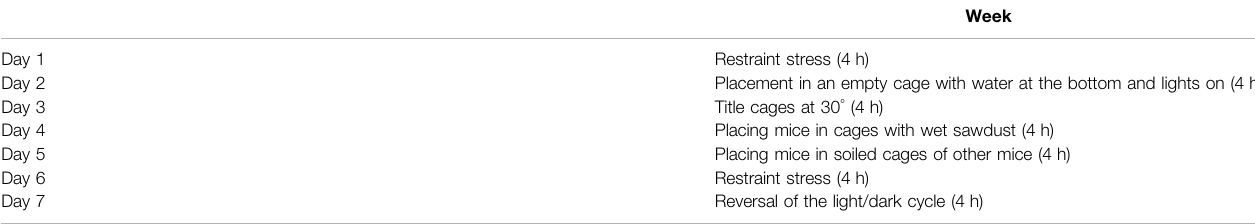
TABLE 1 | List of the stressors used in the CUMS protocol used in this study during the 1st week. These stressors were repeated during the 2nd, 3rd, and 4th weeks at different time points (Doron et al.,